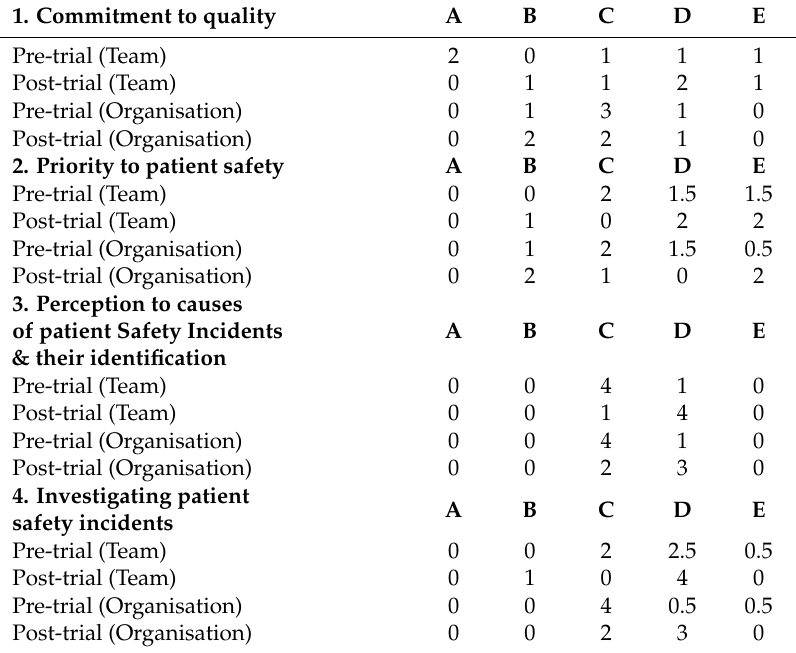
MaPSaF Data Compilation. (MAPSAF)—PRIMARY CARE EVALUATION DATA